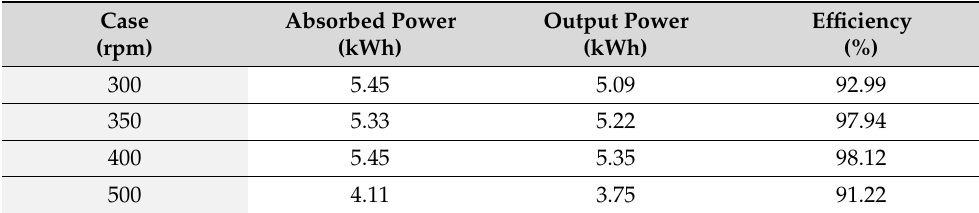
Table 1. Input and output power of the PTO system and efficiency of the PTO system according to the initial reference rpm of the speed control algorithm based on the P&O algorithm.